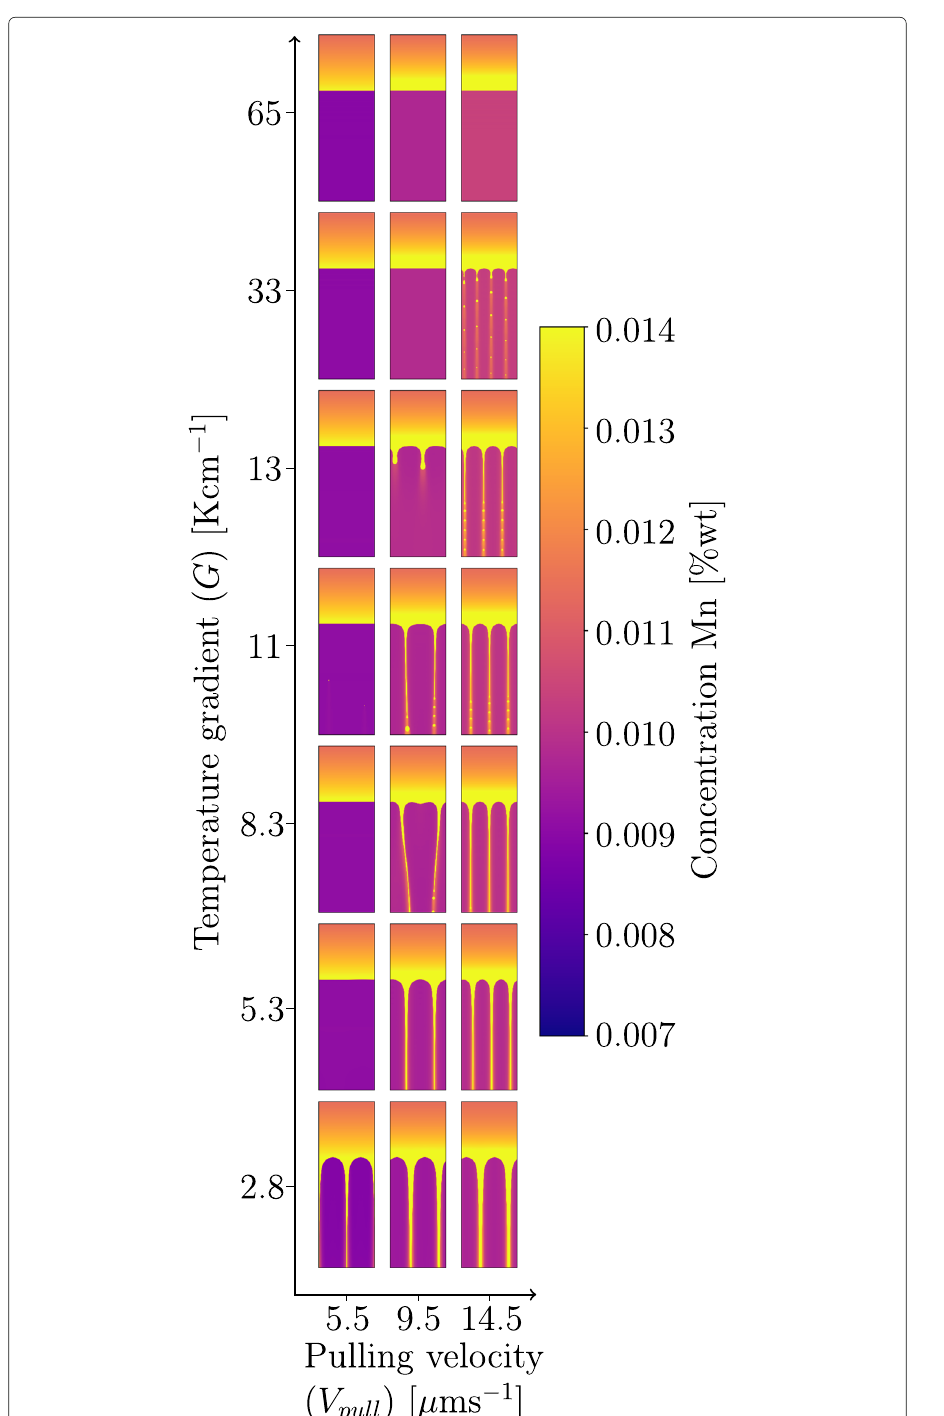
Fig. 14 Growth pattern (Mn-concentration) at t = 400 s, simulated with 1D temperature field calculations. Results are arranged according to the front velocities V front and average temperature gradients (cid:7) G